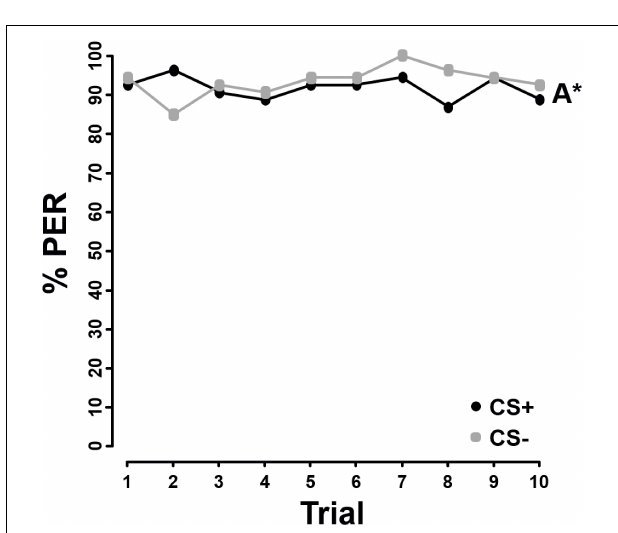
FIGURE 3 | Percentage of proboscis extension responses (% PER) shown by Apis mellifera individuals ( N = 53) in differential chemotactile conditioning to pollen enriched with 10x the natural sterol concentration (10x SP) against pure pollen ( N = 53) over 10 trials. CS+ (black) represents the rewarded conditioned stimulus, CS– (gray) the unrewarded conditioned stimulus. Both, 10x SP and pure pollen were used as CS+ and CS–. As there was no significant difference in learning performance between 10x SP and pure pollen used as CS+ or CS– ( Supplementary Table 4 ), data from both groups were combined. Letters with an asterisk next to the line indicate no significant difference between the two stimuli ( P > 0.05).